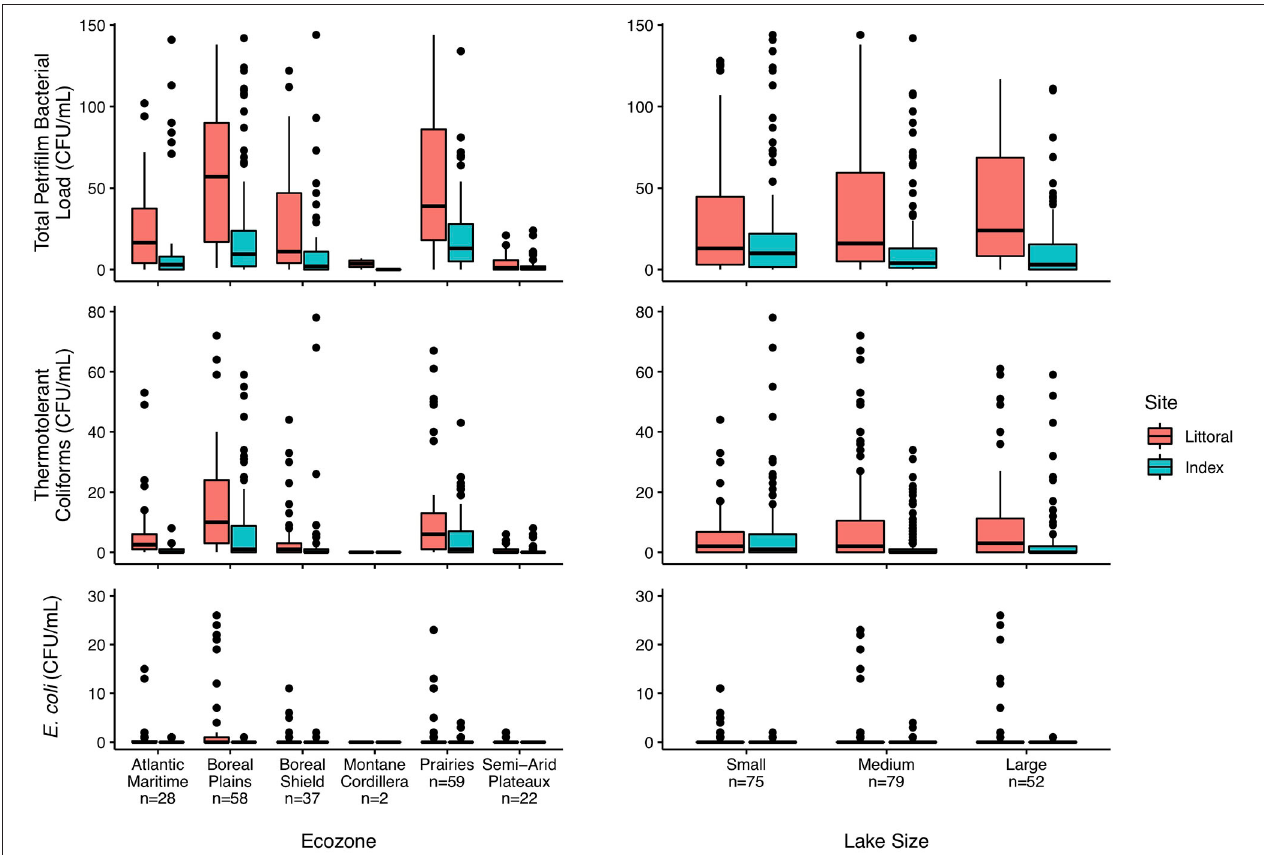
FIGURE 3 | Boxplots of total Petrifilm, thermotolerant coliform, and E. coli counts segregated by lake ecozone and size. Centerlines show the median bacterial load, the upper and lower limits correspond to the first and third quartiles, with the whiskers showing the lowest and highest values within 1.5 times the interquartile range. Dots represent lakes with bacterial loads beyond the whiskers. Lakes were sampled in six of the 18 terrestrial ecozones in Canada, and lakes were classified by size, where small lakes are ≥ 0.1 to < 0.5 km 2 , medium lakes are ≥ 0.5 to < 5 km 2 , and large lakes are ≥ 5 to < 100 km 2 (